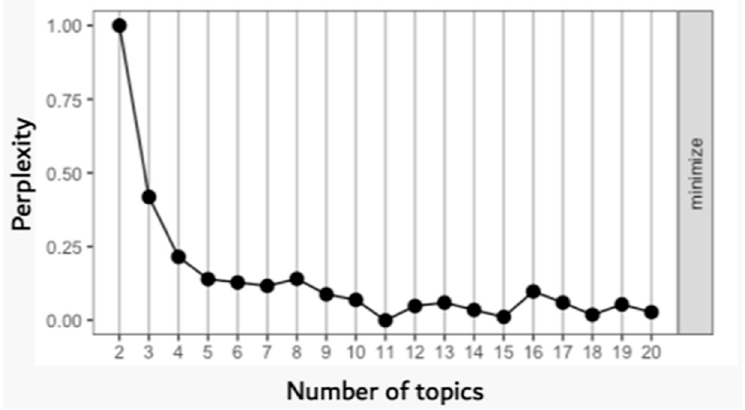
Figure 3. Perplexity of topic model.